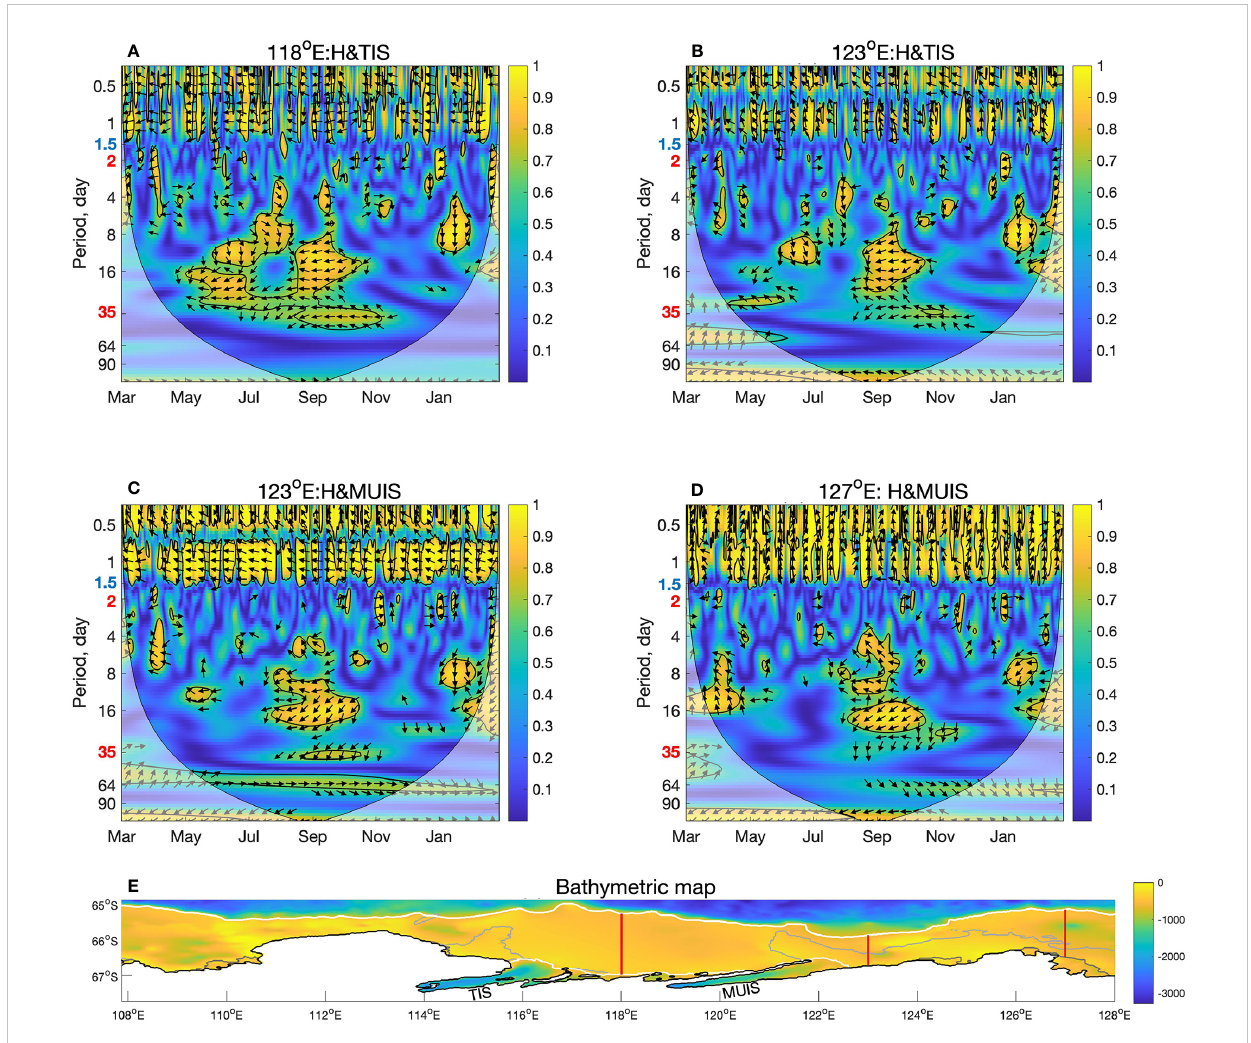
FIGURE 5 The wavelet coherence between area-averaged heat transport and ice shelf basal melt rate. The ice shelves analysed are identi fi ed along with the transect as the title of each subplot which are marked on the location map at the bottom of the fi gure. Top row are TIS area-averaged basal melt rate time series for 2014 in the 118° E transect (A) and the 123° E transect (B) . Middle row are wavelet coherence between area-averaged heat transport and the MUIS area-averaged basal melt rate time series for 2014 in the 123° E transect (C) and the 127° E transect (D) . The bottom map (E) shows bathymetric depth and the three longitudinal transects (in red) from the ice shelf front to the continental shelf